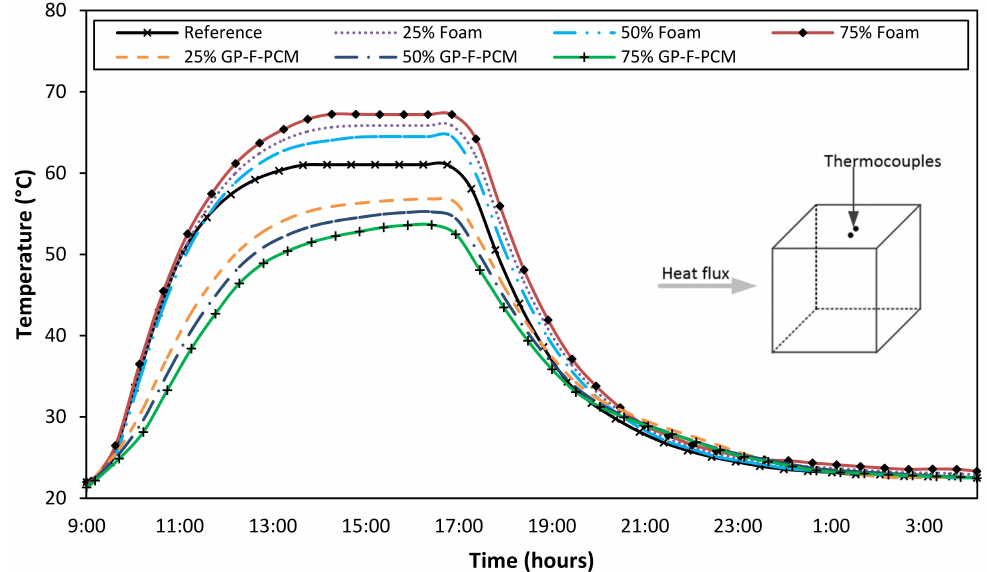
Figure A2. Comparison of temperature variations at the 3rd side of all the cubes.